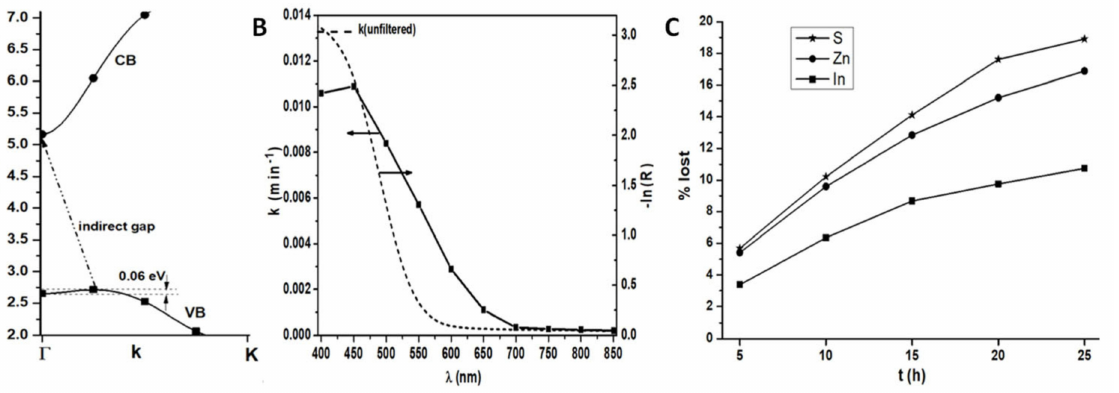
Figure 9. ( A ) Results of a hybrid DFT calculation showing the indirect character of the ZnIn 2 S 4 bandgap. ( B ) spectral response of ZnIn 2 S 4 in photocatalytic degradation of aqueous HCOOH, compared with its diffuse reflectance absorption spectrum. ( C ) Time dependence of ZnIn 2 S 4 photo- corrosion during HCOOH photocatalysis: amount of each element gone into solution, as verified with chemical analysis (Adapted from Ref.